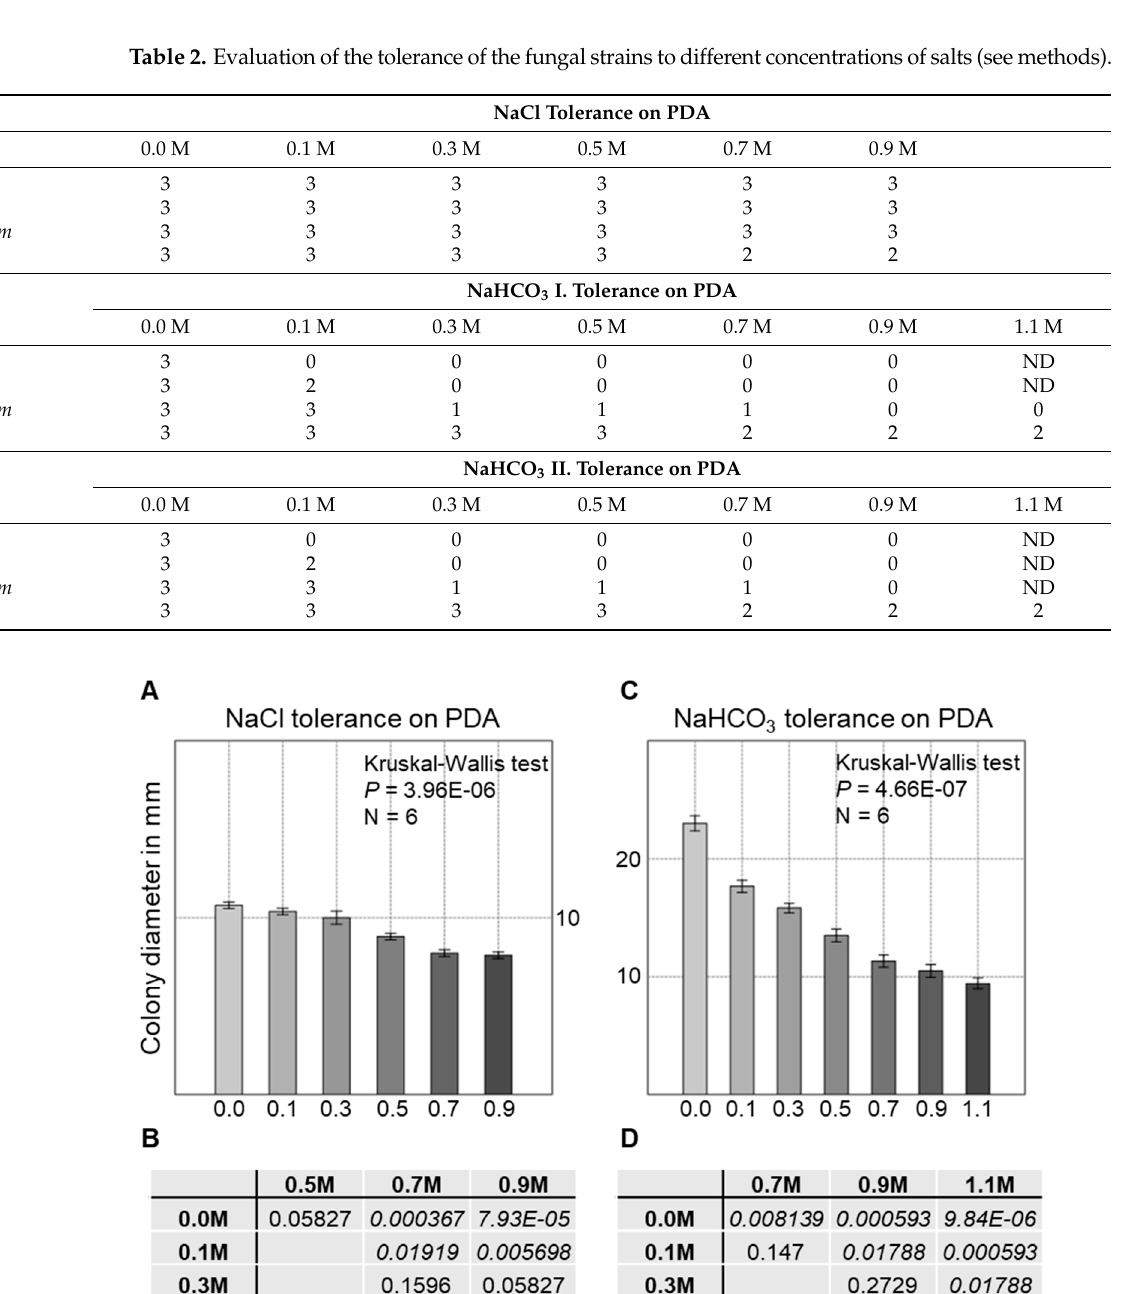
Figure 5. Colony formation of the AGSC12 strain on NaCl- and NaHCO 3 -containing PDA plates. ( A ) Colony diameters after 7 days of cultivation at different NaCl concentrations. There were significant differences among the values (Kruskal-Wallis test, P = 3.96 × 10 − 6 ). ( B ) The data indicate those concentrations when the measured colony diameters showed significant discrepancies according to the Dunn’s post hoc test. The values are the relevant P values. Only those cases are shown where the P values were less than 0.5. Significant values are in italics. ( C ) Colony diameters at various NaHCO 3 (II) concentrations after 14 days of cultivation. There were significant differences among the values (Kruskal-Wallis test, P = 4.66 × 10 − 7 ). ( D ) Same as ( B ) for the NaHCO 3 concentrations. Whiskers on the bar charts represent standard deviations. N stands for sample size.